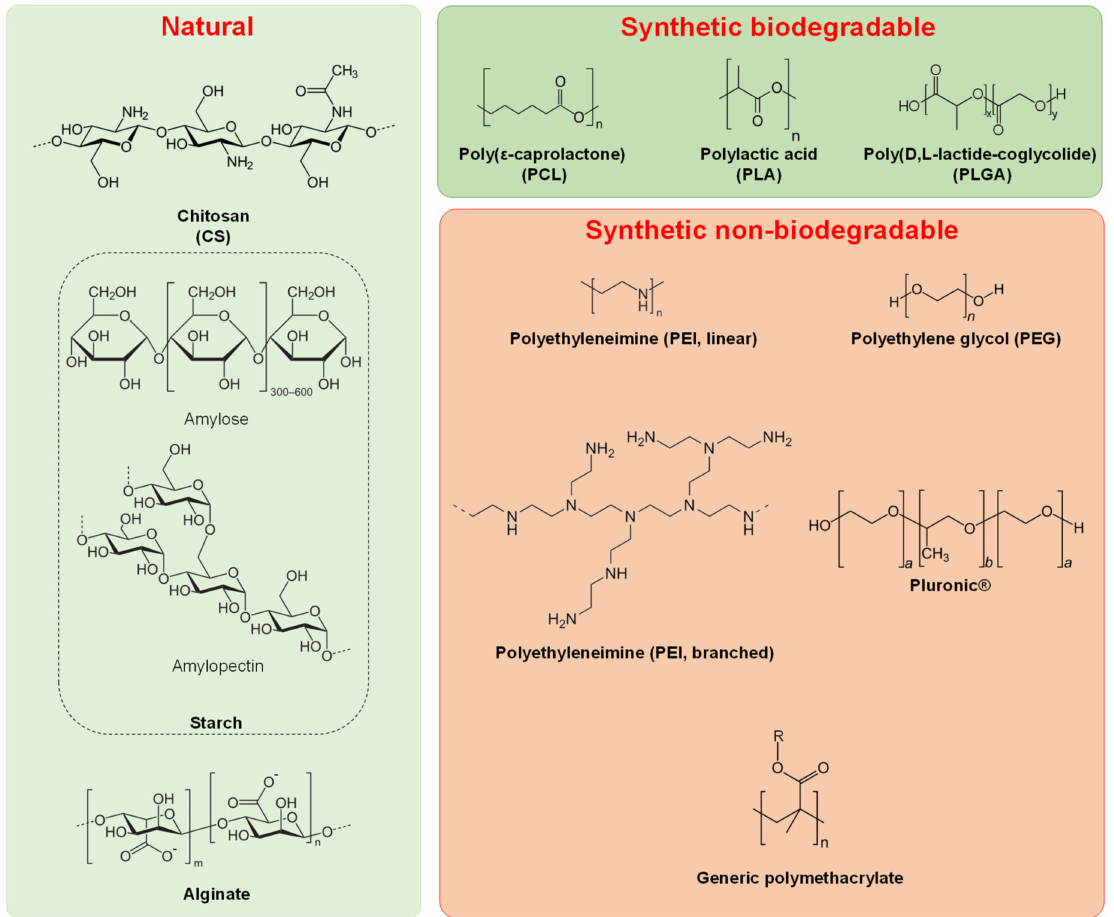
Figure 1. Chemical structures of the main polymers used to produce nano particles (NPs) against oral diseases. These are grouped in natural polymers, as well as biodegradable and non-biodegradable synthetic